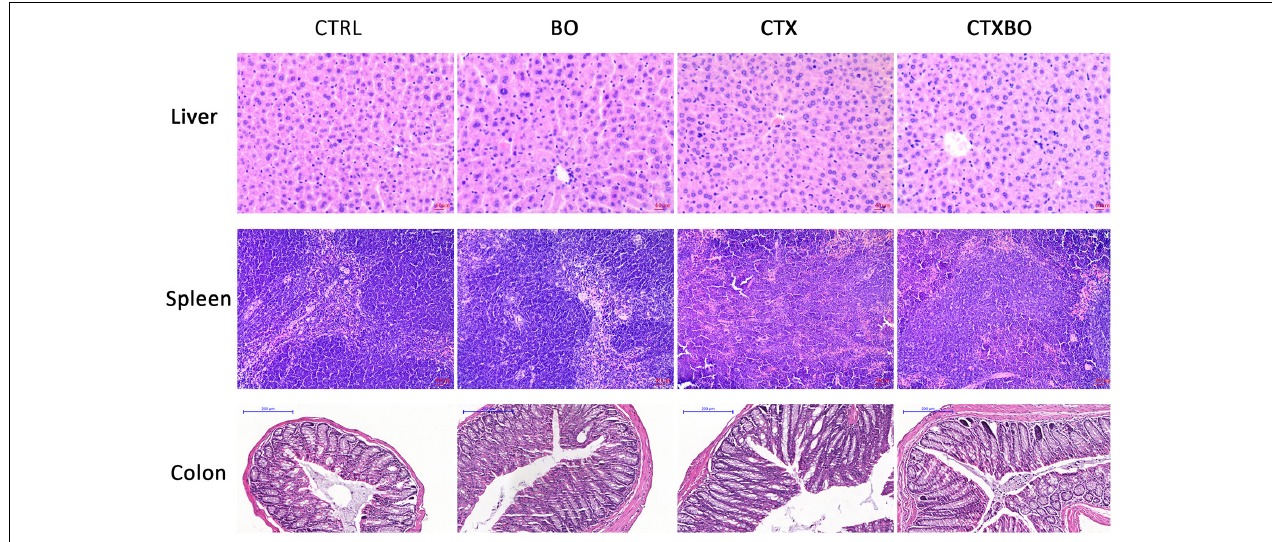
FIGURE 4 | Impact of B. ovatus ELH-B2 on the tissue histology of immunocompetent and immunosuppressed mice.